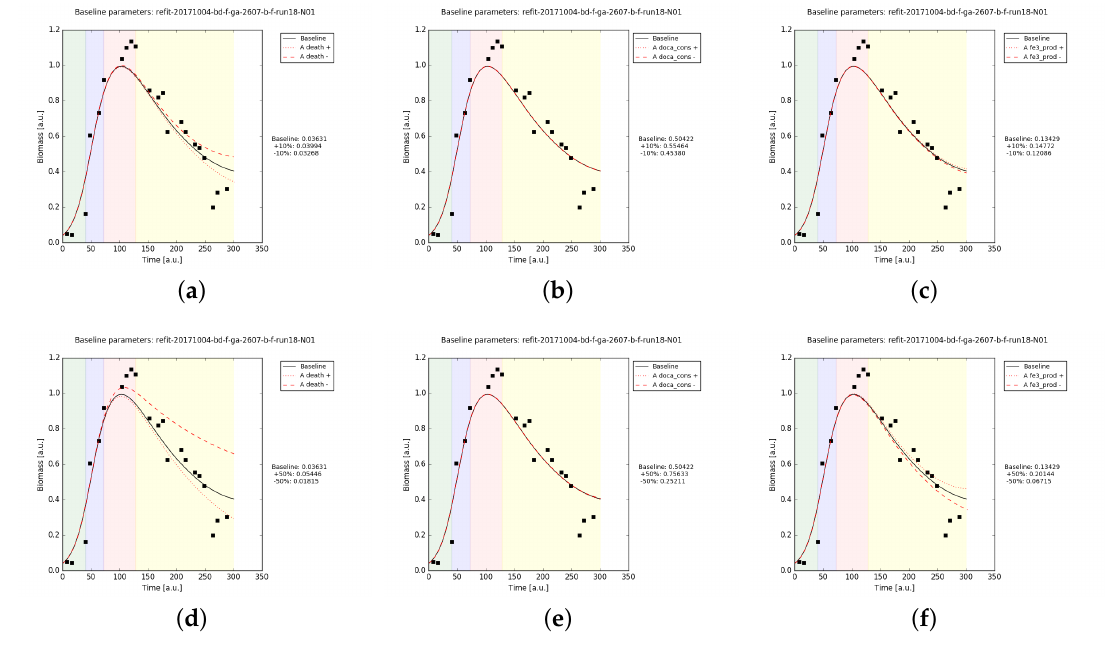
( A ) ( A ) and v prod , Fe DOC A